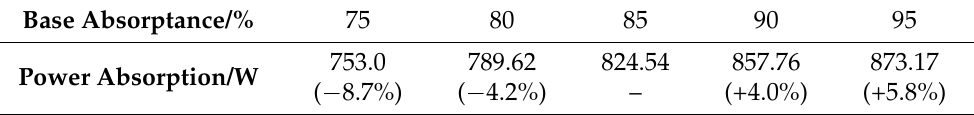
Table 3. Power absorption for different surface absorptances ∗ . Base Absorptance/%